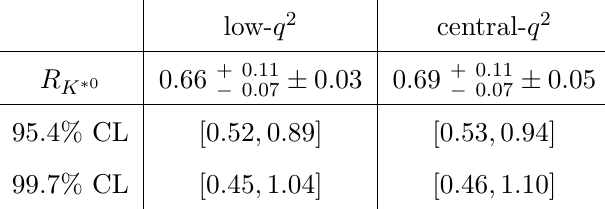
Table 5 . Measured R ratios in the two q 2 regions. The (cid:12)rst uncertainties are statistical and K (cid:3) 0 the second are systematic. About 50% of the systematic uncertainty is correlated between the two q 2 bins. The 95.4% and 99.7% con(cid:12)dence level (CL) intervals include both the statistical and systematic uncertainties.